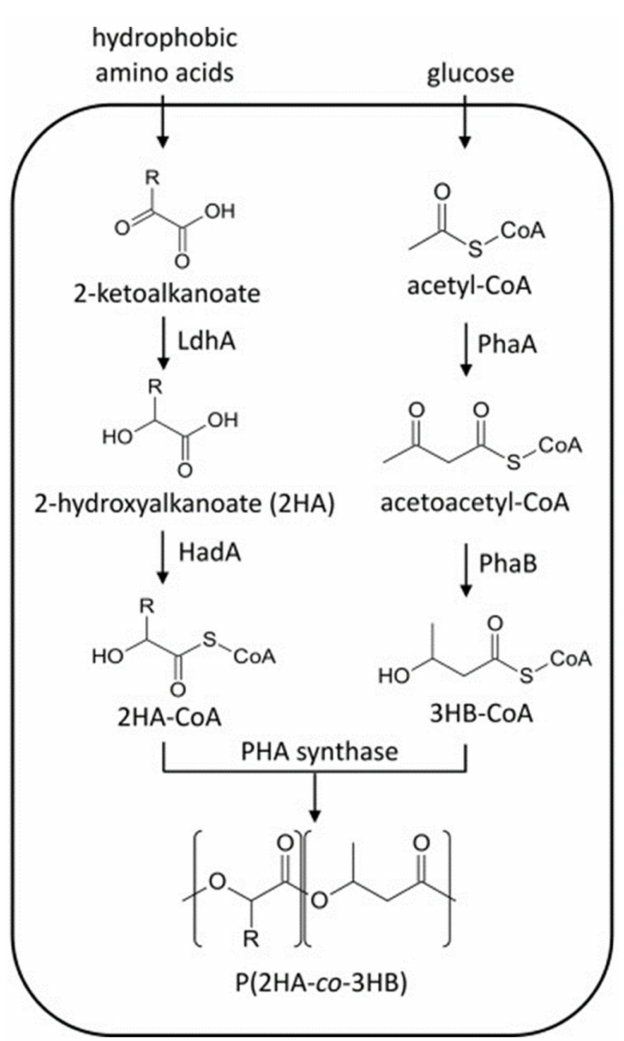
Figure 5. Poly (2-hydroxyalkanoate-co-3-hydroxybutyrate) (P2HA-co-P3HB) biosynthesis pathways in engineered Escherichia coli . Reproduced with permission from [113]. Copyright 2020 Elsevier